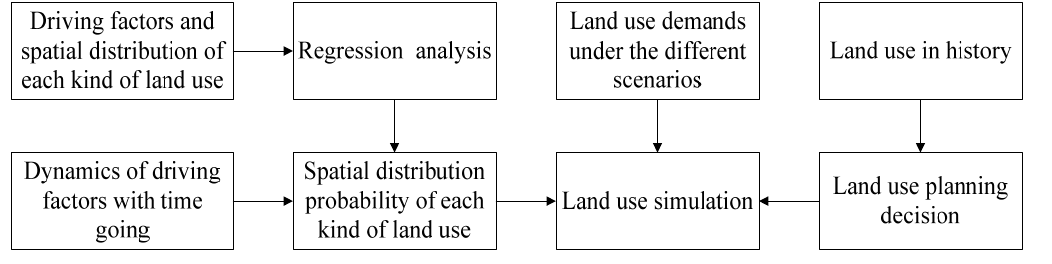
Figure 2. Flow chart of the conversion of Land Use and its Effects (CLUE)